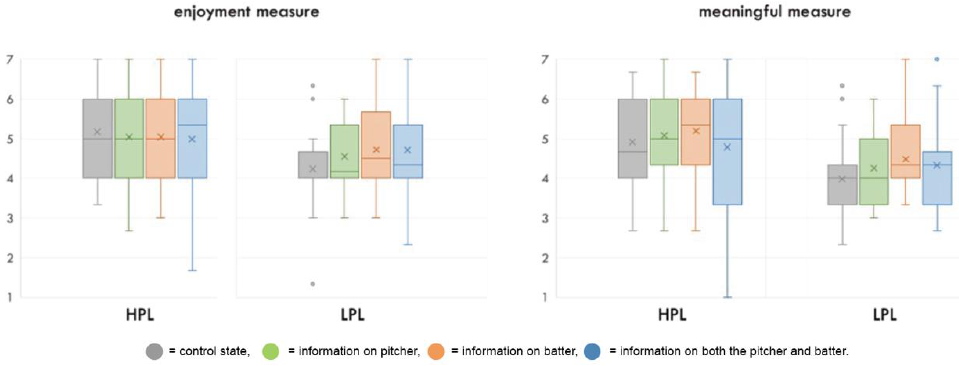
Figure 2. Visual information had no substantial effect on HPL, while the presence or absence of visual information affected the effect of the LPL group in different scales.